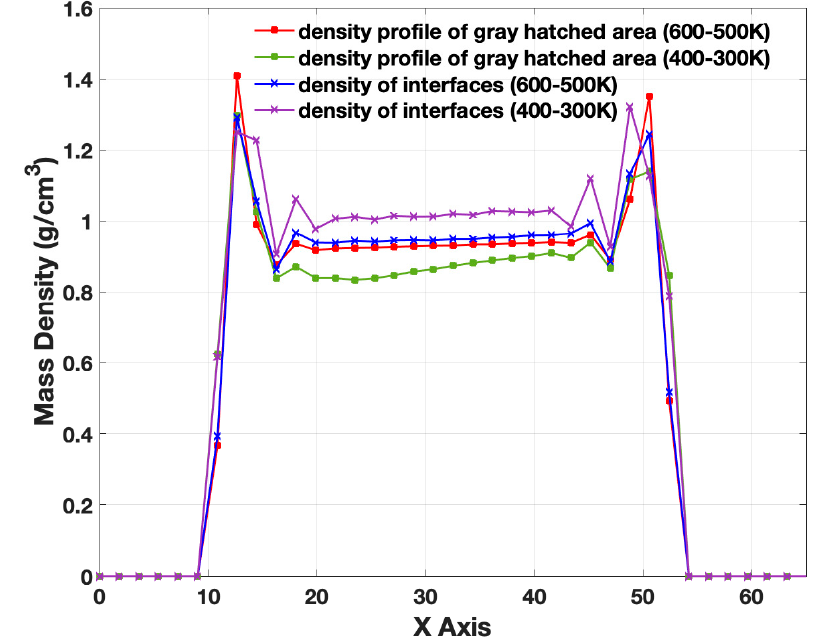
Figure 6. Mass density profile of water along the X (see Figure 1) direction when the average temperature is only varied—cases B1 and B5 (see Table 1 for conditions). The red and green lines represent the regions shown as the bulk phase (grey hatched areas) and the adjoining interface regions (green hatched areas) shown in Figure 1. The blue and purple lines, respectively, show the interface regions (red hatched areas) and the adjoining “double” interface regions (unhatched white) shown in Figure 1.